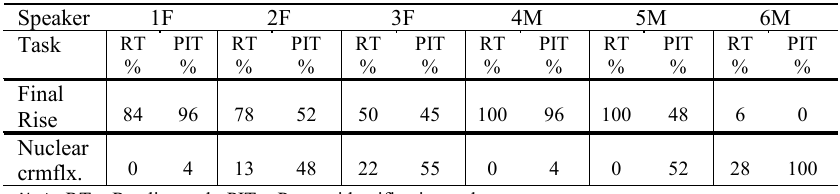
Table 3. Contour type production according to